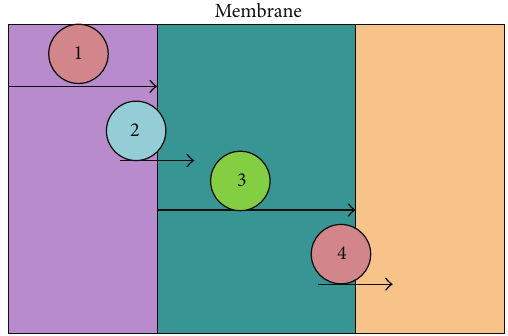
Figure 3: Steps involved in transport of component through a pervaporation